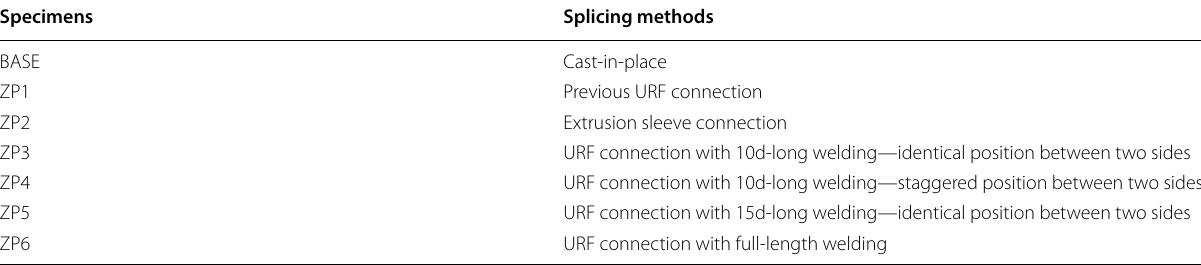
d refers to the diameter of U-type longitudinal